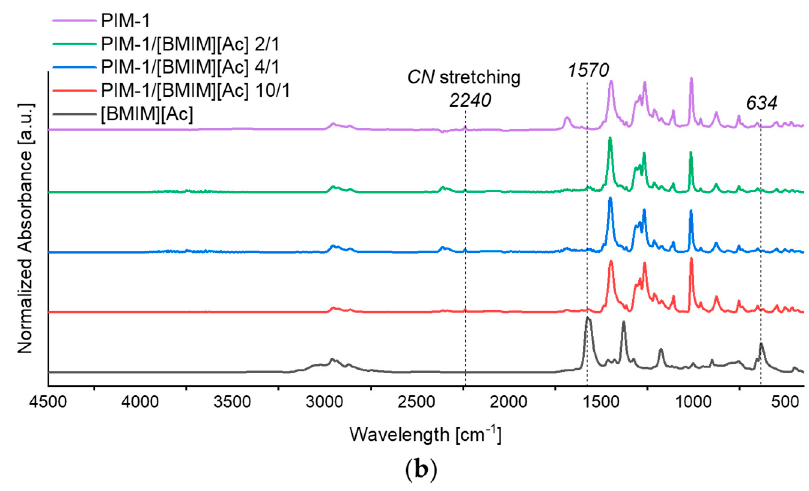
Figure 3. Attenuated total reflectance (ATR) spectra of blended PIM-1/ILs membranes compared to PIM-1: ( a ) [BMIM][Succ] spectra; ( b ) [BMIM][Ac] spectra.